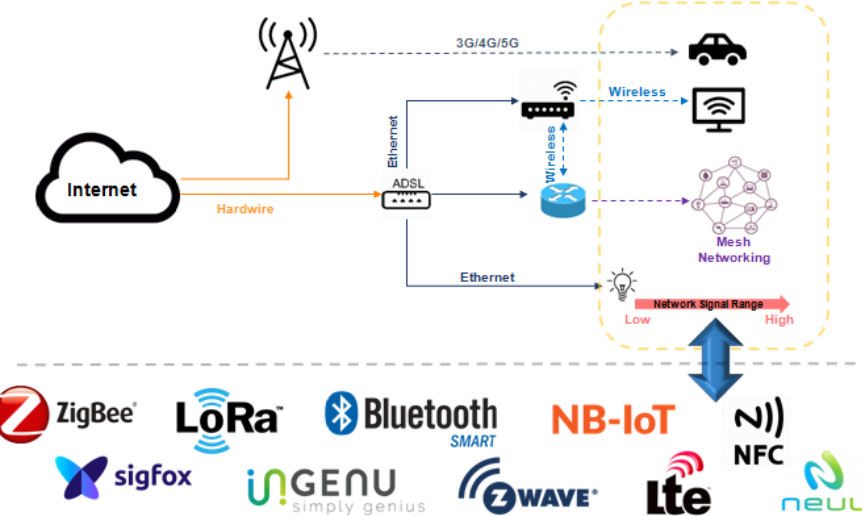
Figure 1. Illustration of an IoT Network Architecture and a plethora of available